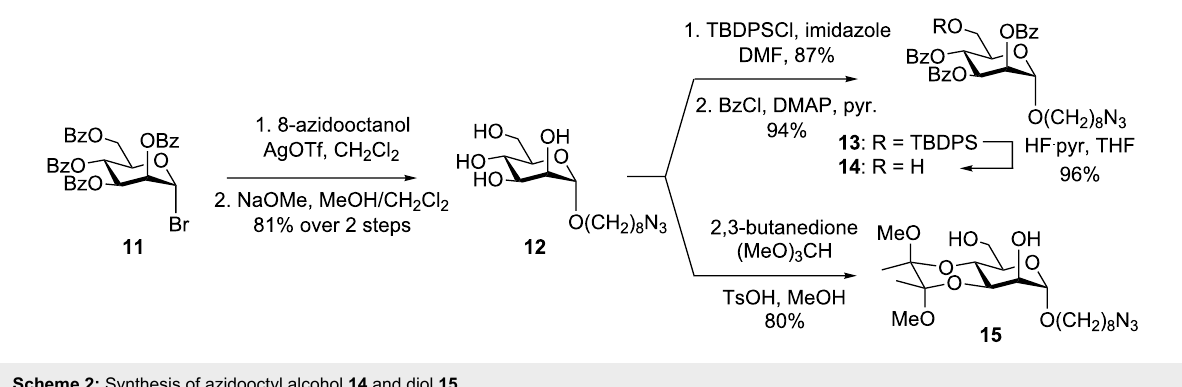
Figure 2: Target di- and trisaccharide glycoconjugate fragments of PIMs and LM.